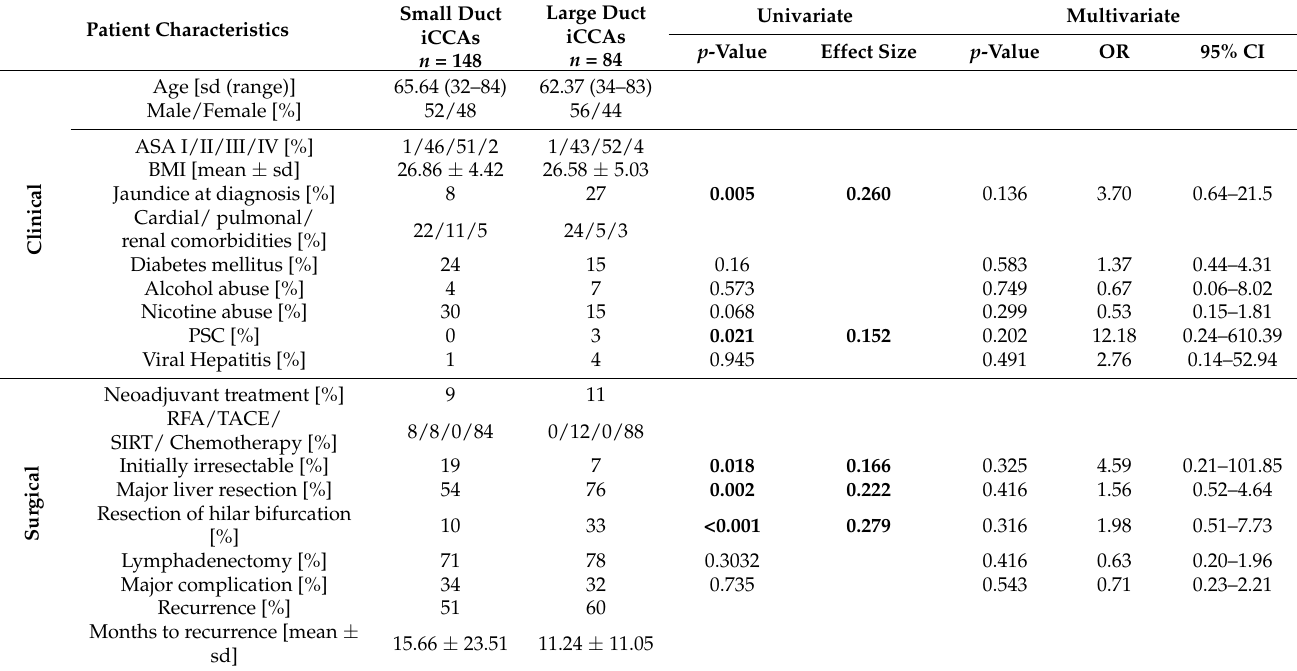
Table 1. Clinical patient